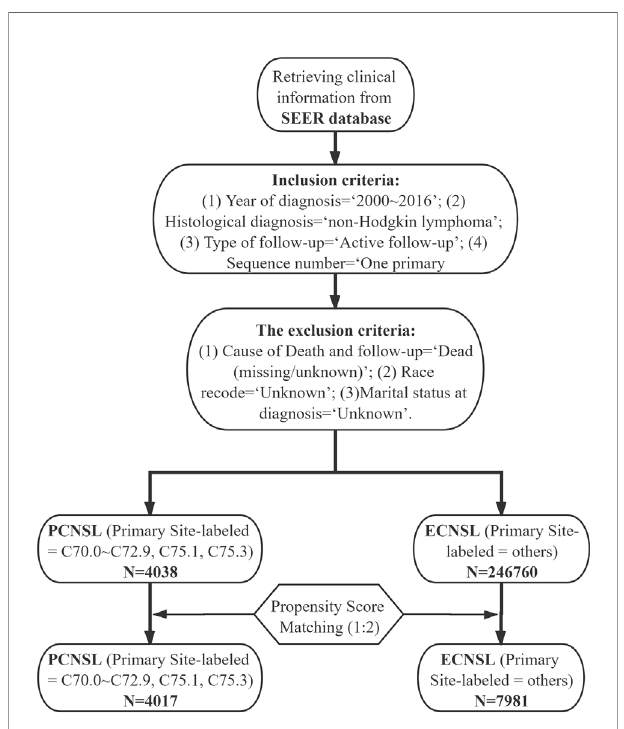
FIGURE 1 | Flowchart outlining the process of inclusion, exclusion, and PSM.